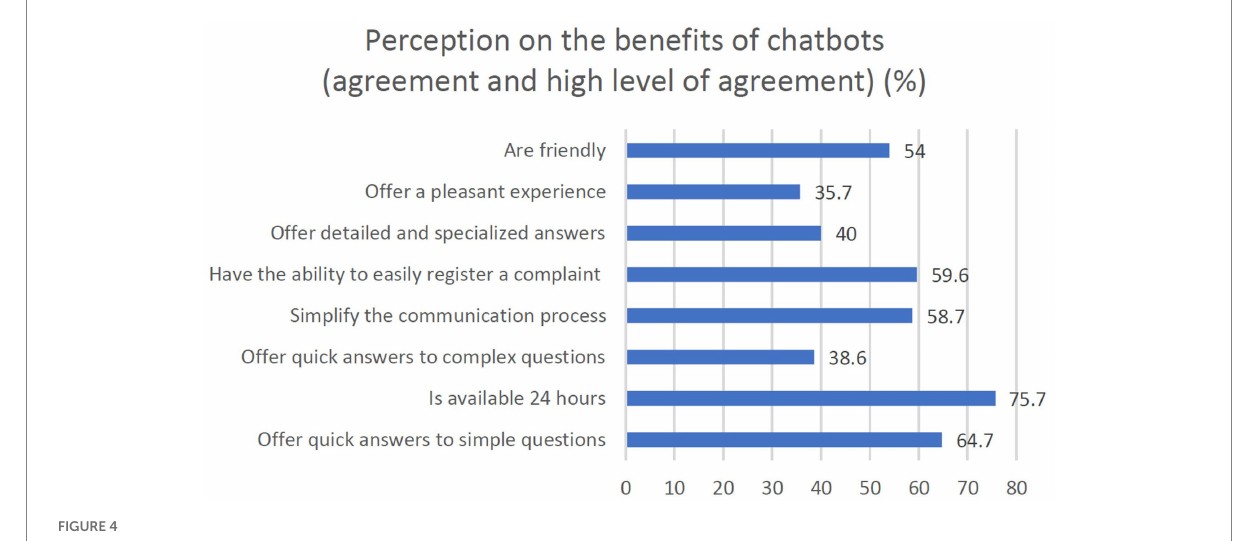
FIGURE 4 The perception of the benefits of chatbots.